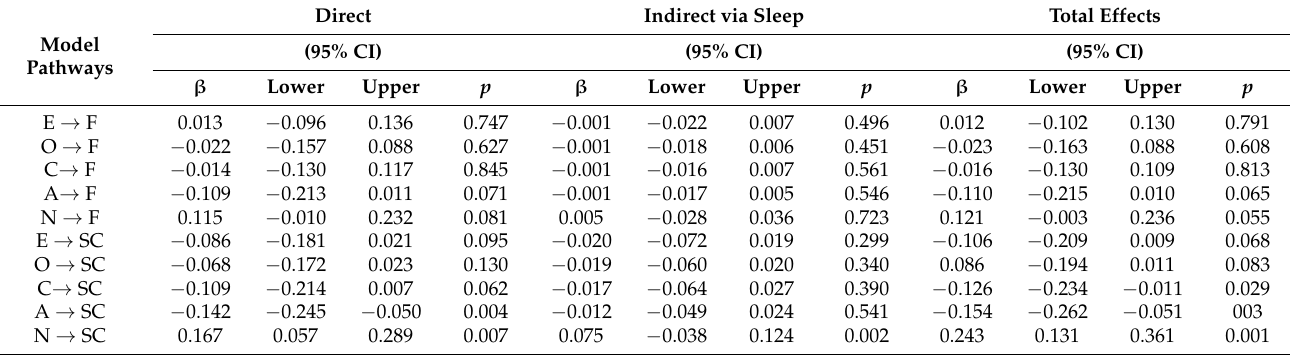
Table 4. Standardized effects and corresponding 95% bias-corrected bootstrap CIS for model 1.